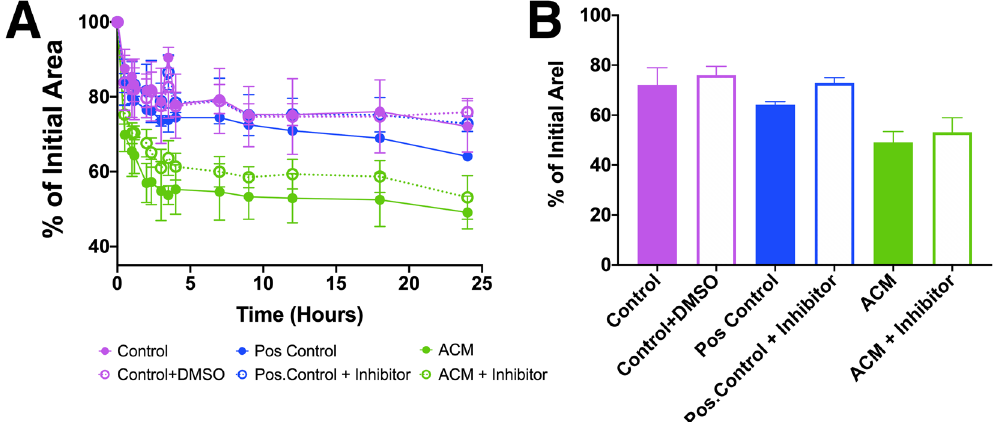
Figure 5. Inhibition of TGF- β 1 receptor using SB505124 reduces but does not diminish fibroblast mediated compaction of fibrin gels treated with ACM. ( A ) Percent compaction of fibrin gels after 24 hours treated with control, control with DMSO, positive control, positive control with inhibitor, ACM, and ACM with inhibitor (mean ± SD, n = 3). ( B ) Compaction of the gels at 24 hours. ACM treated and inhibited samples compacted